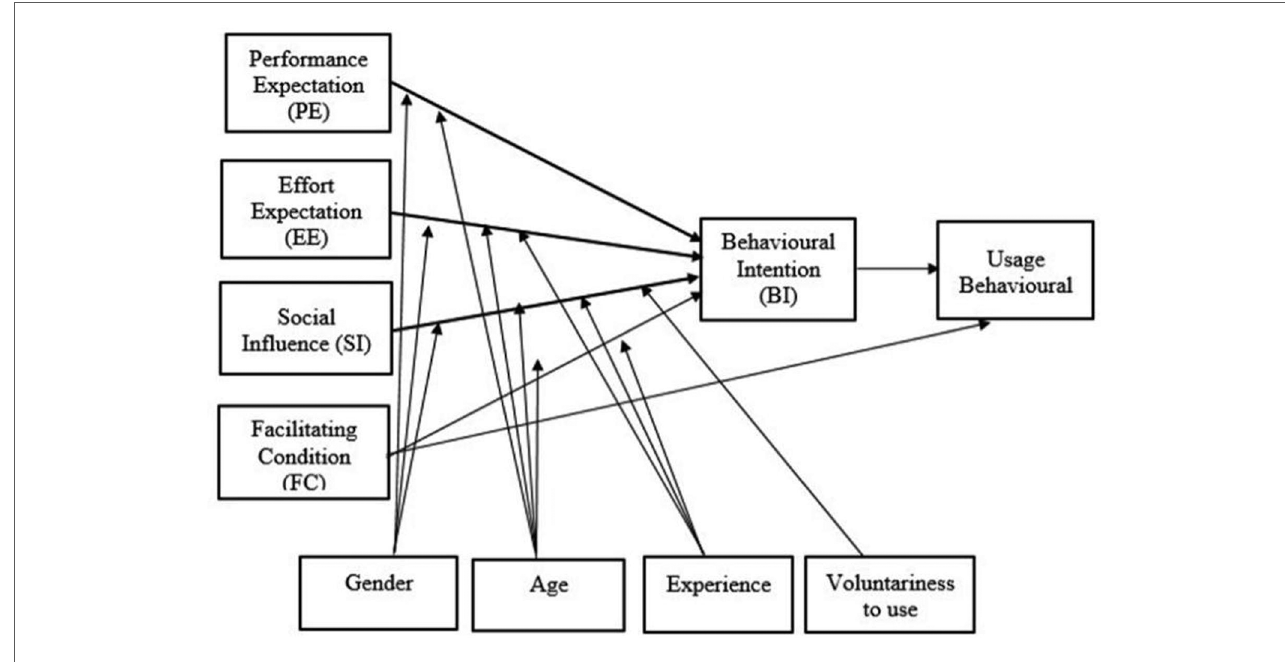
FIGURE 1 UTAUT model (26), available via license: CC bY-NC